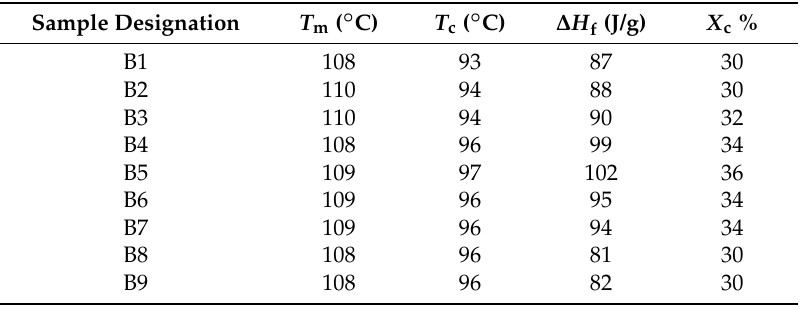
Table 2. T m , T c , ∆ H m , and X c % of the pristine LDPE and its composite films.